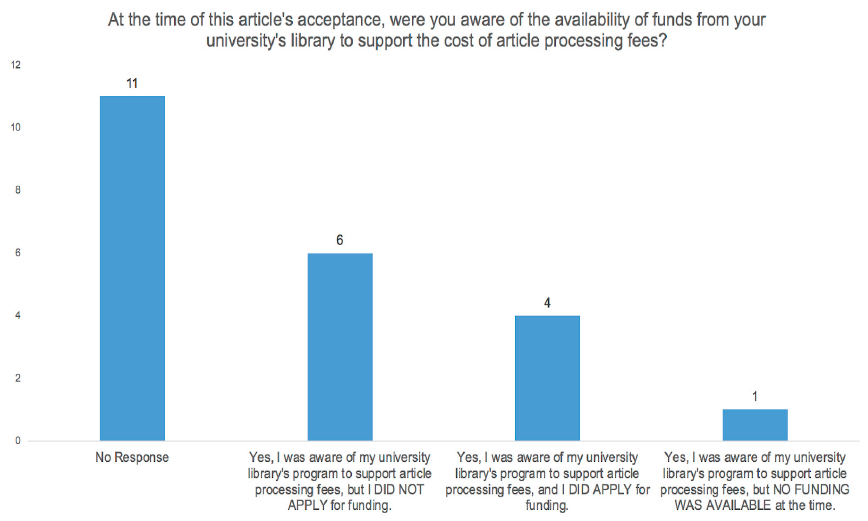
Figure 4. Awareness of University Library Funding.